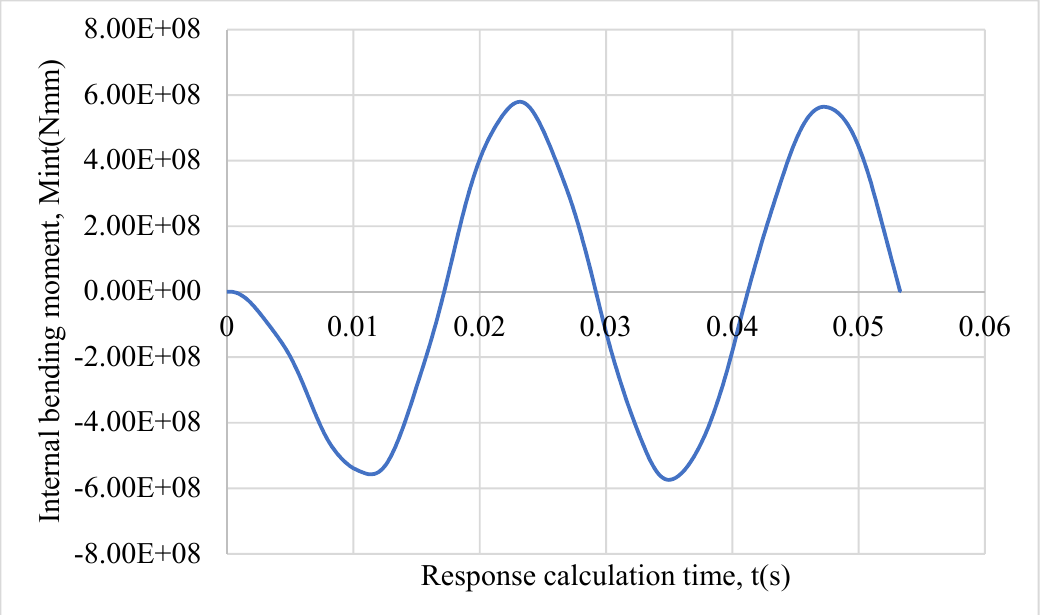
Figure 8. Internal bending moment of mid-section when the applied dynamic bending moment M d = 1.0M ult_s and the dynamic load duration time T d = 0.9 T 0 .